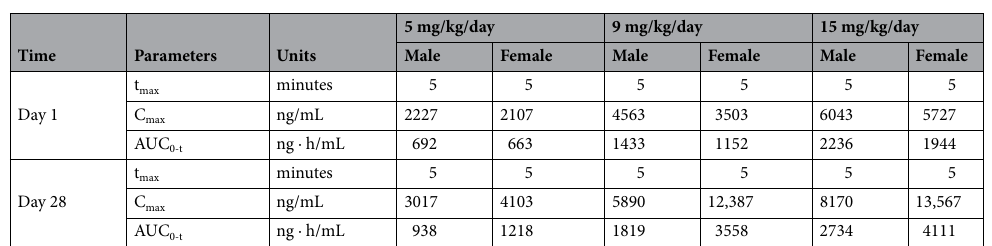
Table 7. Pharmacokinetic parameters of SET-M33 on day 1 and day 28 of 4 weeks of daily intravenous (slow bolus) administration to male and female rats at 5, 9 and 15 mg/kg/day (group mean values). C max maximum plasma concentrations, t max time at which C max occurred, AUC 0-t area under the curve from zero to last quantifiable sampling time. Statistical analysis is not applicable to these